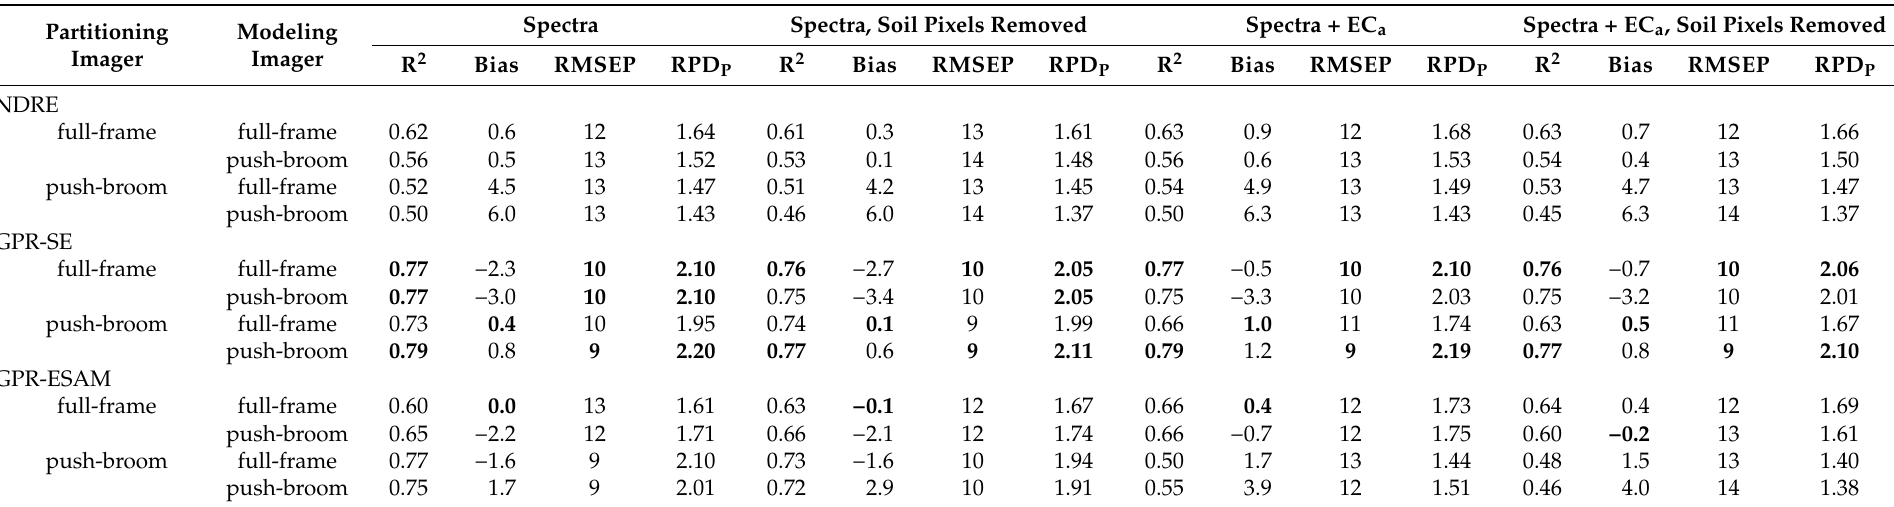
Table 2. Dry matter prediction performance metrics of individual model families across the testing datasets according to the device which provided spectra for dataset partitioning and for model training. The four column blocks examine the effects of removing soil pixels from the hyperspectral imagery prior to model training or augmenting the spectral data with measurements of apparent soil electrical conductivity. The three row blocks correspond to the predicted variables. The values of bias and RMSEP are in gm − 2 . The individual rows of each block compare the performance of the cameras and predictive model formulations. The results with the best metrics for each training dataset are marked in